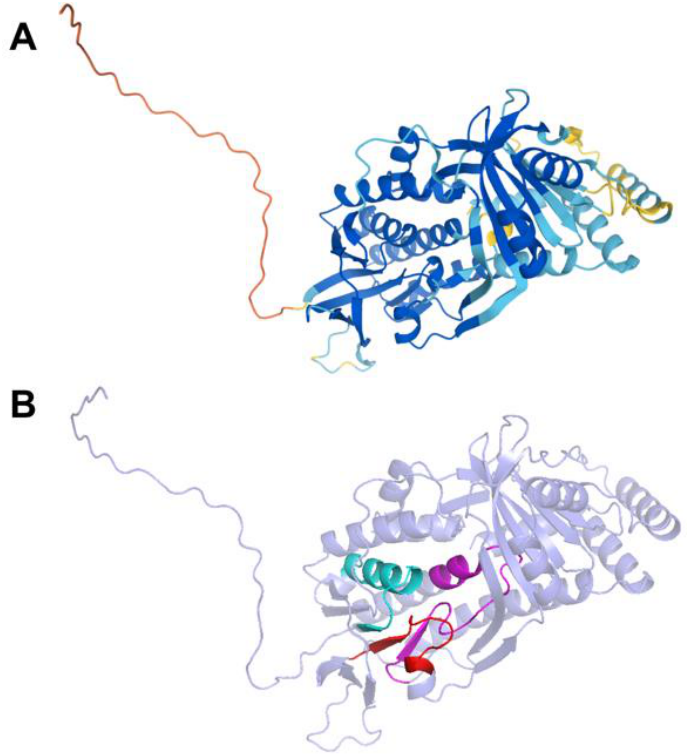
(Figure 20) [39,54]. base